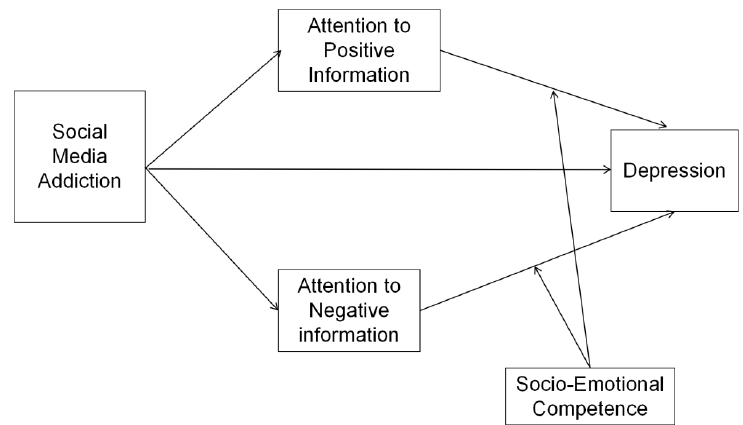
Figure 1. The proposed conceptual scheme.